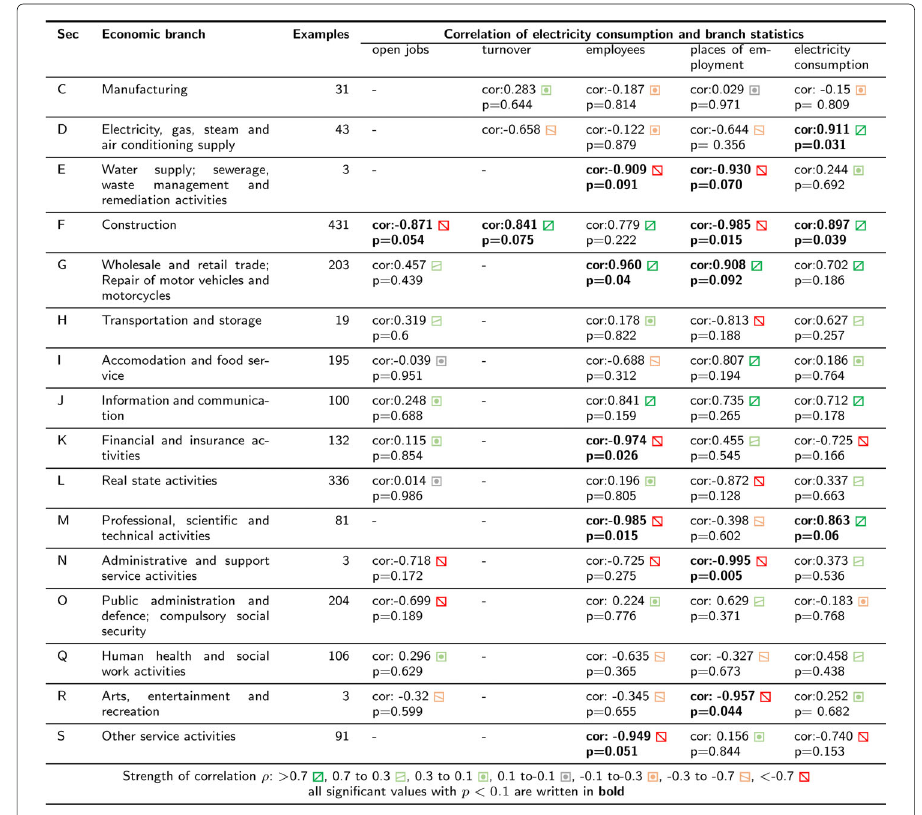
Fig. 2 Correlation of electricity consumption with governmental statistical data in the years